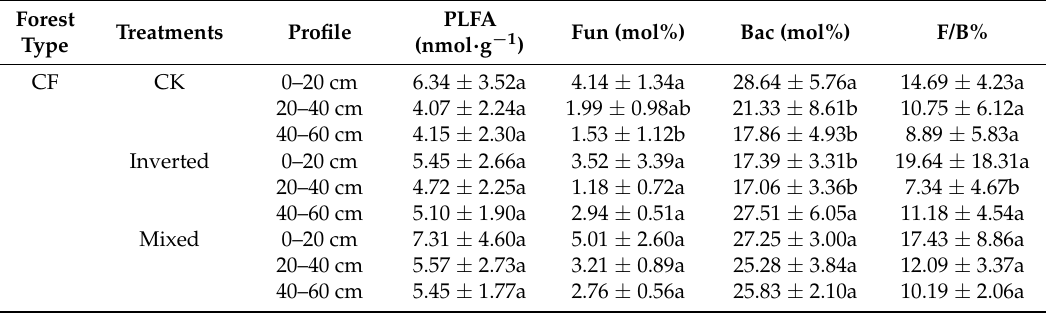
Table 2. Soil microbial community characters in each soil layer over all manipulated soil columns. PLFA, total PLFA; Fun, fungi; Bac, Bacteria; F/B, the ratio of fungal to bacterial biomass. Error bars represent the standard errors of the mean ( n = 4). Different letters represent significant differences (LSD test, p <